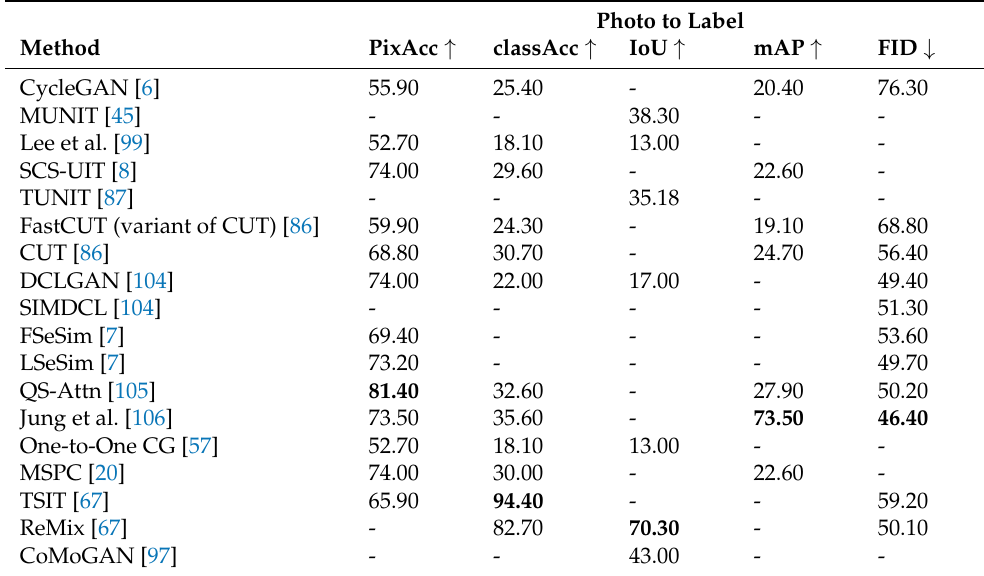
Table 2. CityScapes results from reviewed papers. Bold numbers are the results of the best performing models in a given metric. Results are taken from papers and “-” indicates that no results have been found. Results taken from articles.